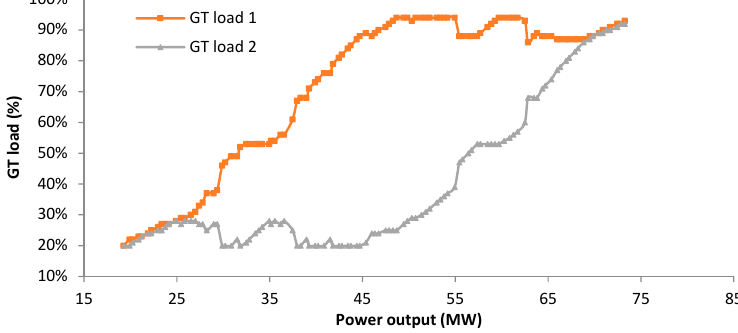
Figure 2. Example of optimum load share between two topping gas turbines of a combined cycle.